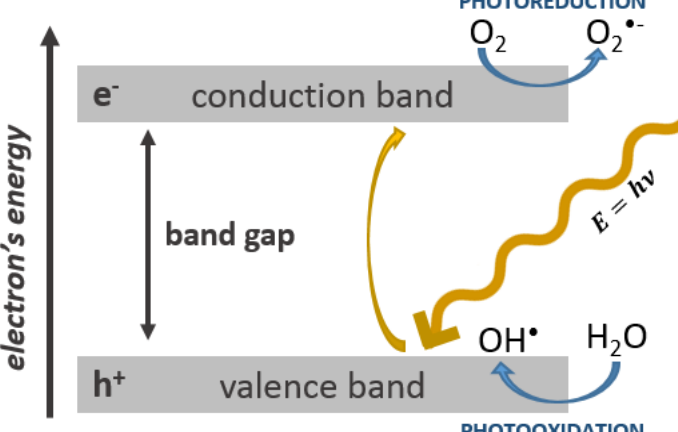
Figure 2. Bandgap in a semiconducting material. A valence band electron (e − ) is excited to the conduction band upon light absorption (of ≥ bandgap energy) and leaves a hole in the valence band (h + ) (according to [4,13]).